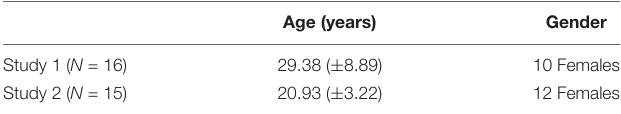
TABLE 1 | Demographic data from the participants who completed Studies 1 and